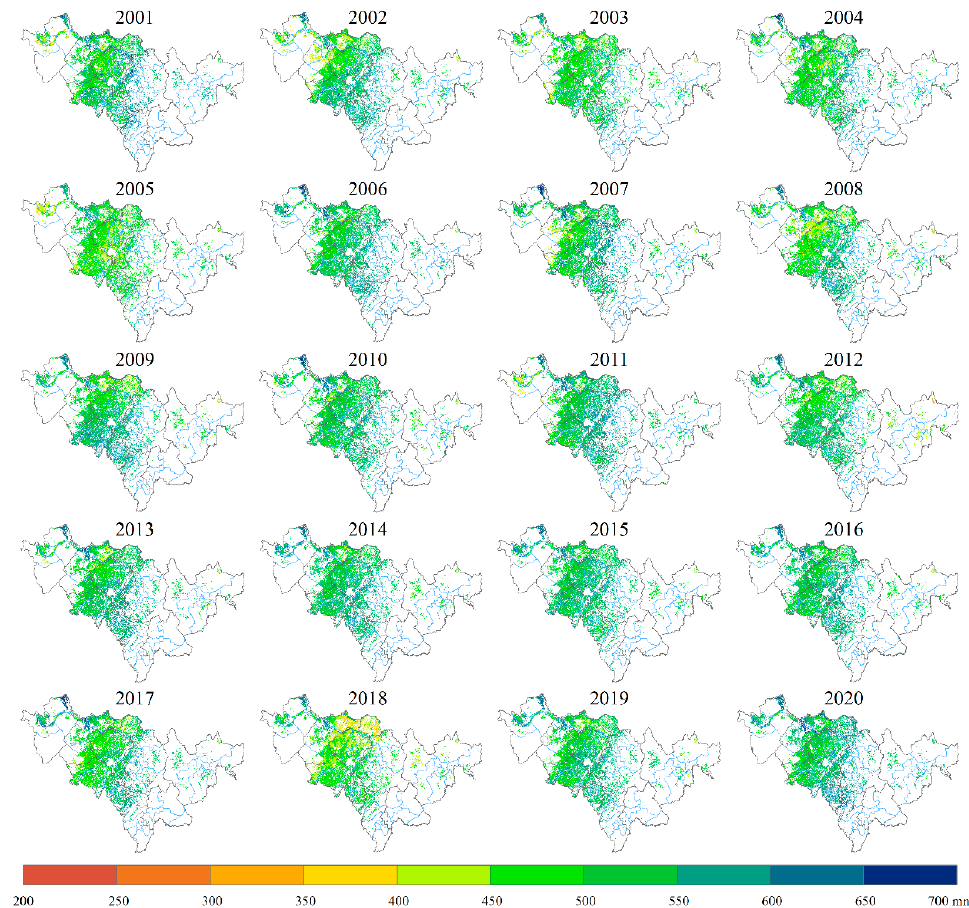
Figure 13. ET a of spring maize during growing season over the years.